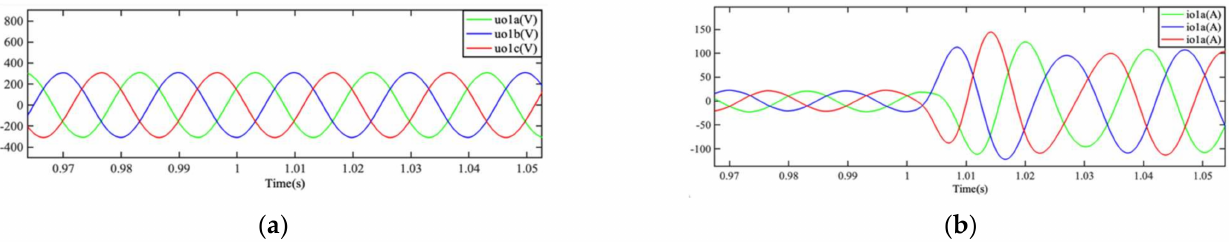
Figure 10. Simulation results in operating mode 2. ( a ) Output voltages of inverter 1; ( b) Output currents of inverter